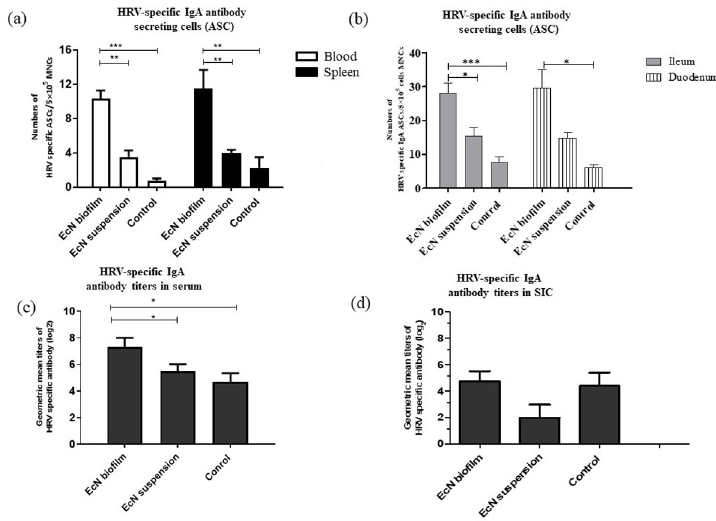
Fig 2. EcN biofilm significantly increased HRV-specific IgA Antibody Secreting Cells (ASCs) in systemic and intestinal tissues and increased HRV-specific IgA antibody titers in serum and Small Intestinal Contents (SIC). (a) HRV-specific IgA ASCs in systemic cells; (b) HRV-specific IgA ASCs in intestinal cells; (c) HRV-specific IgA antibody titers in serum and (d) SIC. No significant differences were observed in intestinal tissues. Data represent means ± SEM. Significant differences ( � p < 0.05, �� p < 0.01, ��� p < 0.001) are indicated. Gnotobiotic pigs were transplanted with human infant fecal microbiota (HIFM) at 4 days of age, post-HIFM transplantation day (PTD) 0. Pigs were fed a deficient diet. Probiotic was given to respective groups at PTD 11, followed by challenge with virulent human rotavirus (HRV) on PTD 13/post-challenge day (PCD) 0 and pigs were euthanized on PTD 27/PCD